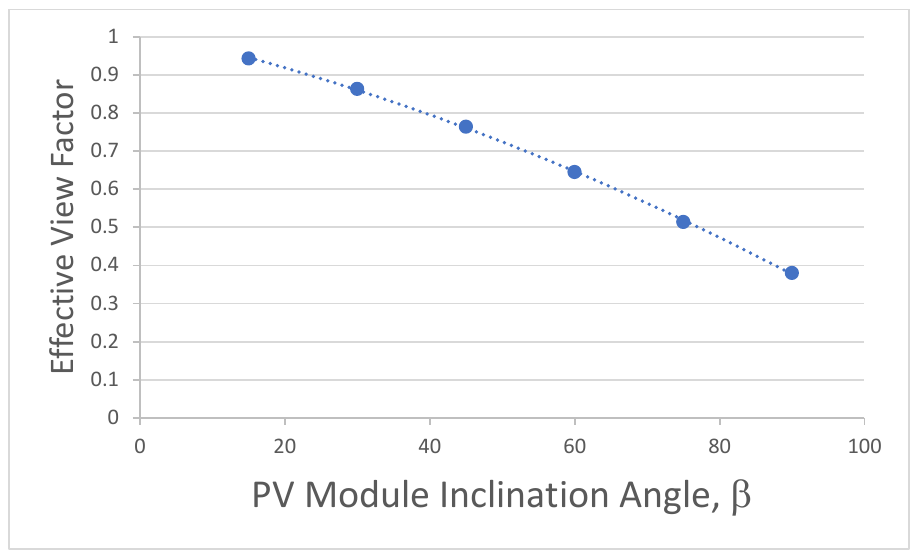
Figure 2. Relationship between the effective view factor and angle of inclination β of the PV module. This relationship is valid only for the given geometry.